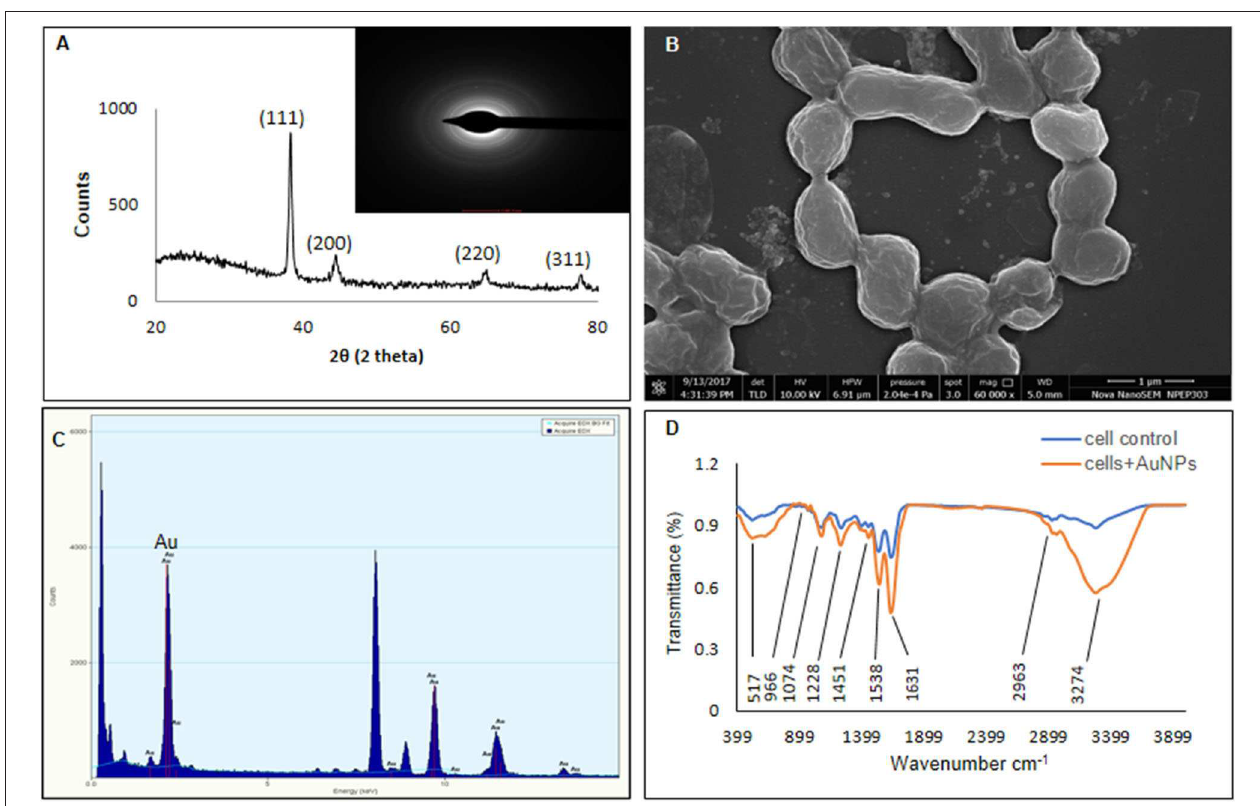
FIGURE 4 | Characterization of AuNPs (A) XRD, (B) FESEM, (C) EDS, and (D)